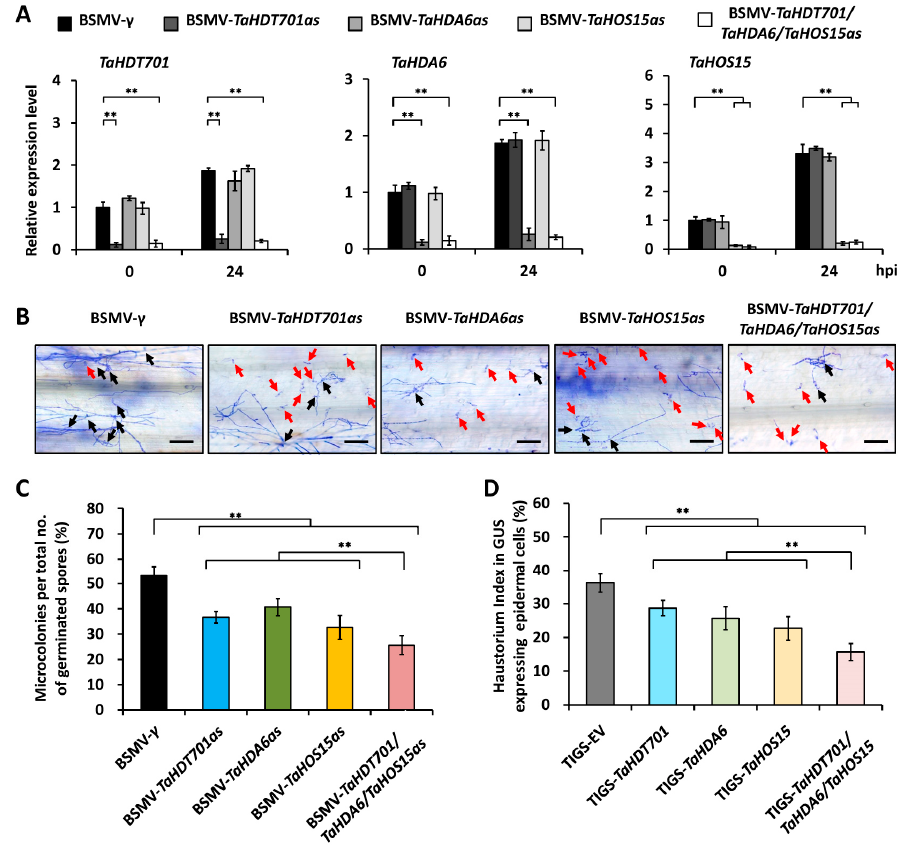
Figure 4. Silencing of TaHDT701 , TaHDA6 , and TaHOS15 compromises wheat susceptibility to Bgt. ( A ) Relative transcript abundance of TaHDT701, TaHDA6, and TaHOS15 on wheat plants with di ff erent background. The expression level in BSMV- γ wheat leave at 0 hpi was set to 1. ( B ) Bgt microcolony formation type on wheat plants with di ff erent background. Conidia that germinated and finally established microcolonies are indicated with black arrows, and conidia that germinated but failed to establish microcolonies are indicated with red arrows. Bars = 100 µ m. ( C ) Statistical analysis of Bgt microcolony formation on wheat plants with di ff erent background. For each treatment, at least 500 Bgt- wheat interaction sites were separately counted. ( D ) Statistical analysis of Bgt haustorial formation in wheat epidermal cells with di ff erent background. At least 100 cells were analyzed in one experiment. For ( A ), ( C ), and ( D ), three independent biological replicates per treatment were statistically analyzed ( t -test, ** p < 0.01).